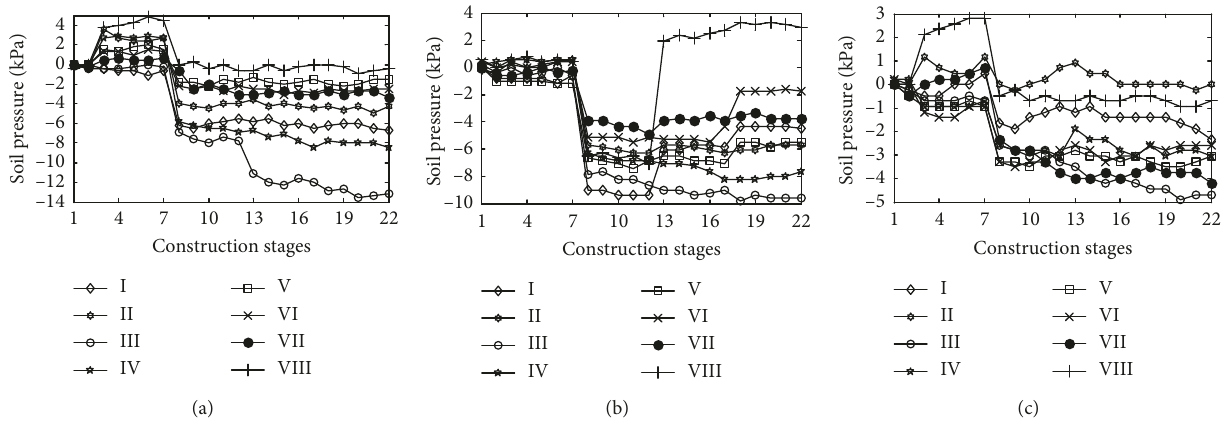
Figure 18: Comparison of soil pressure below the excavation in the horizontal direction. (a) 107. (b) 110. (c)